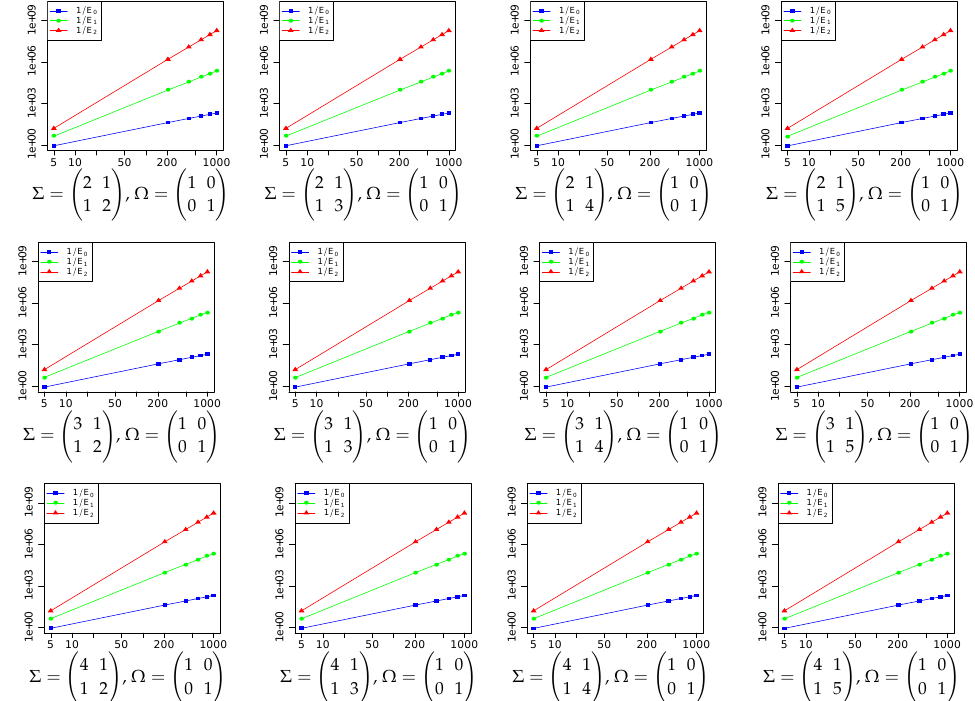
Figure 2. Plots of 1/ E i as a function of ν , for various choices of Σ . Both the horizontal and vertical axes are on a logarithmic scale. The plots clearly illustrate how the addition of correction terms from Theorem 1 to the base approximation (4) improves